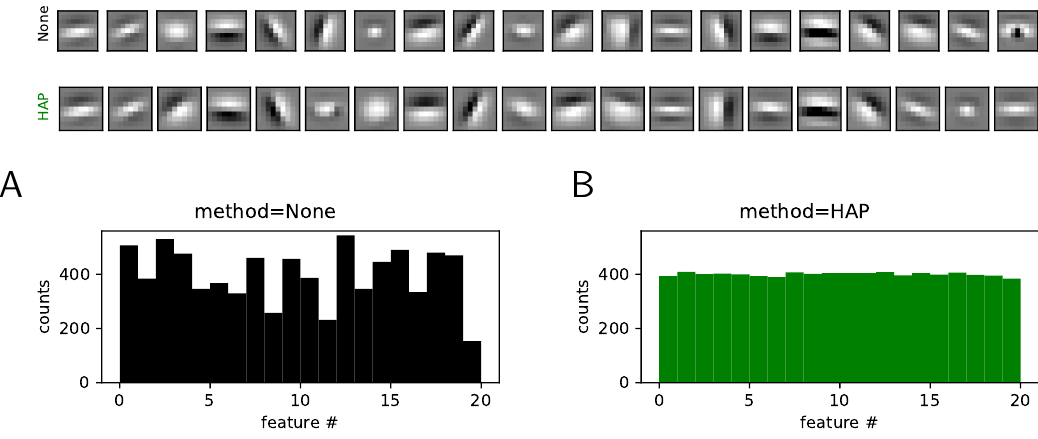
Figure 4. Extension to Convolutional Neural Networks (CNNs). We extend the HAP algorithm to a single-layered CNN with 20 kernels and using the ATT face database. We show here the kernels learned without ( None , top row) and with ( HAP , bottom row) homeostasis (note that we used the same initial conditions). As for the simpler case, we observe a heterogeneity of activation counts without homeostasis, that is, in the case which simply normalizes the energy of kernels (see ( A )). With homeostasis, we observe the convergence of the activation probability for the different kernels (see ( B )). This demonstrates that this heuristic extends well to a CNN